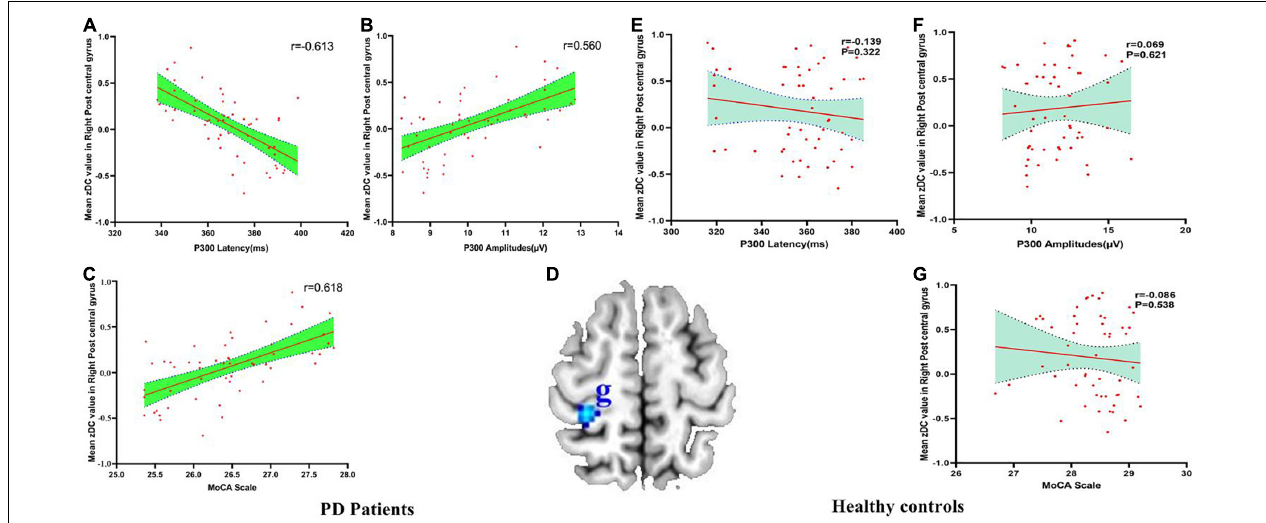
FIGURE 4 | (A–G) The correlation between mean zDC value in the right postcentral gyrus and P300 latency, P300 amplitudes and MoCA scale in PD patients and healthy controls. DC, Degree Centrality. The brain region in the blue Alphabet g was right postcentral